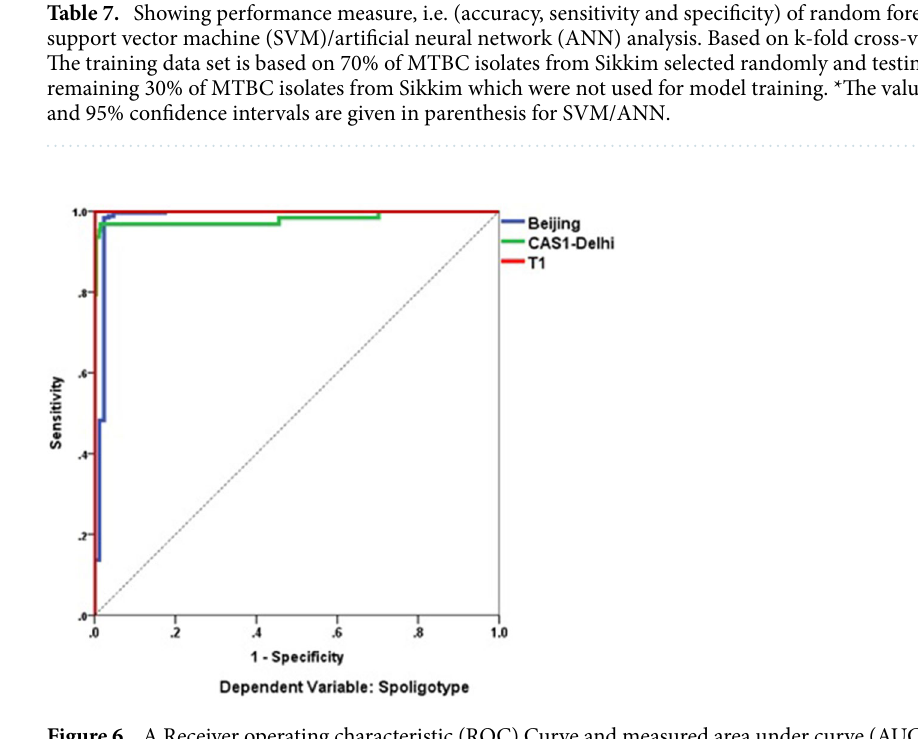
Figure 6. A Receiver operating characteristic (ROC) Curve and measured area under curve (AUC) showing, the classification performance of artificial neural network (ANN) at different levels of cut-offs (threshold levels). This sensitivity versus specificity plot shows the high performance of ANN in predicting spoligotype lineages. Software package R progamme was used for